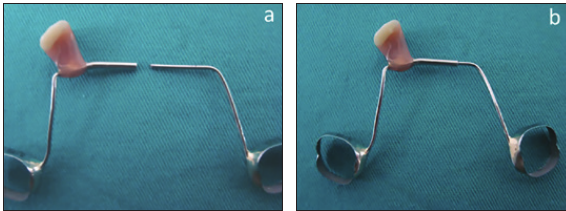
Figure 1. The appliance design (growth-enabling modified fixed palatal space maintainer): a) the appliance in two pieces; b) the appliance before insertion.